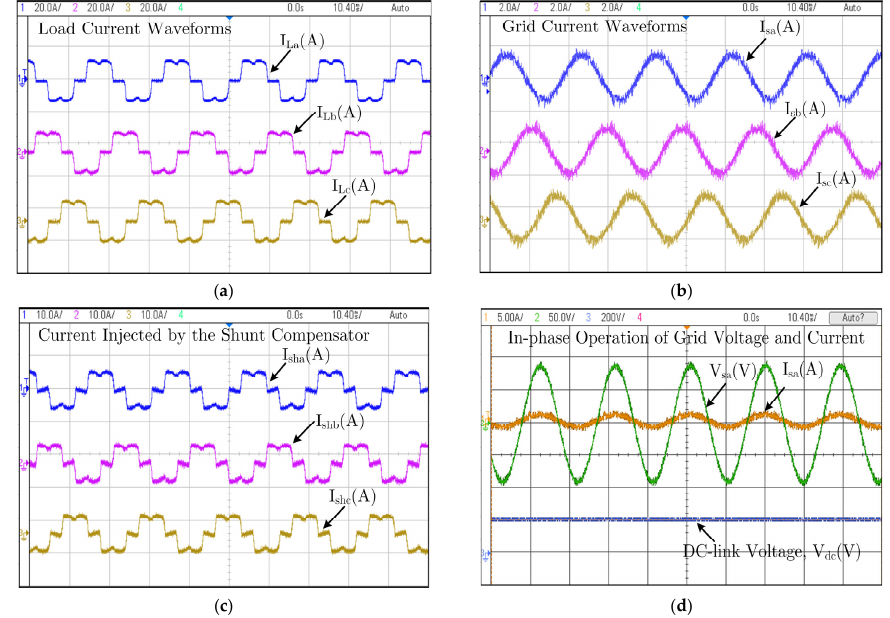
Figure 11. Under steady state condition ( a ) load current; ( b ) grid current; ( c ) current injected by the shunt compensator/DSTATCOM; ( d ) phase relation between voltage and current and DC ‐ link volt ‐ age.